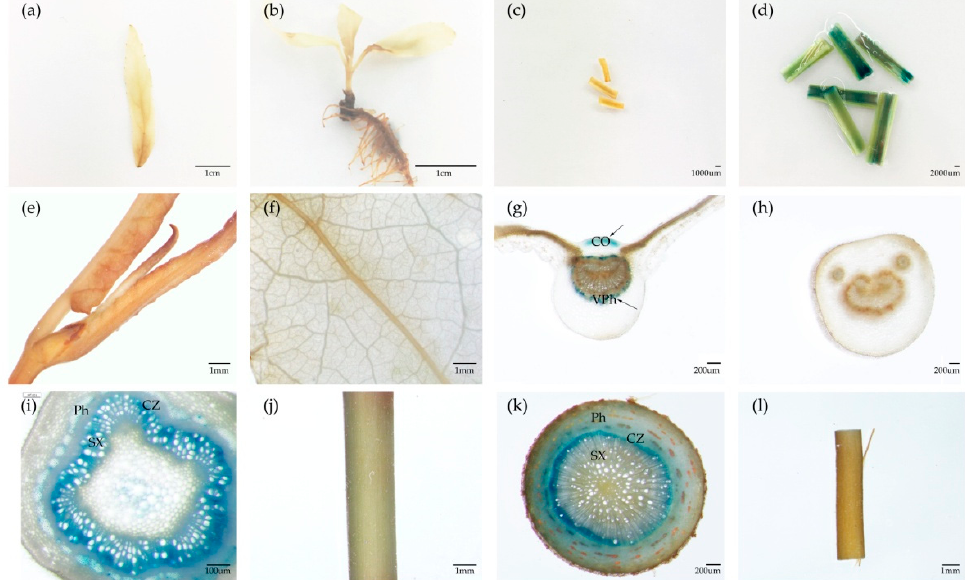
Figure 6. Histochemical GUS assays in various tissues of PtrRHH94pro::GUS transgenic P. trichocarpa . ( a , b ) two-week-old transgenic plantlets on woody plant media (WPM) and its young leaf. ( c , d ) stem internodes (INs) two and five of one-month-old transgenic plantlets on WPM media. ( e , f , j , l ) apical bud, mature leaf, stem IN6 and root of three-month-old transgenic young trees in the greenhouse. ( g – i , k ) cross-sections of main vein and petiole of the eighth leaf, stem IN6 and root from three-month-old transgenic young trees. CO, collenchymas; VPh, vein of phloem; Ph, phloem; CZ, cambial zone; SX, secondary xylem.